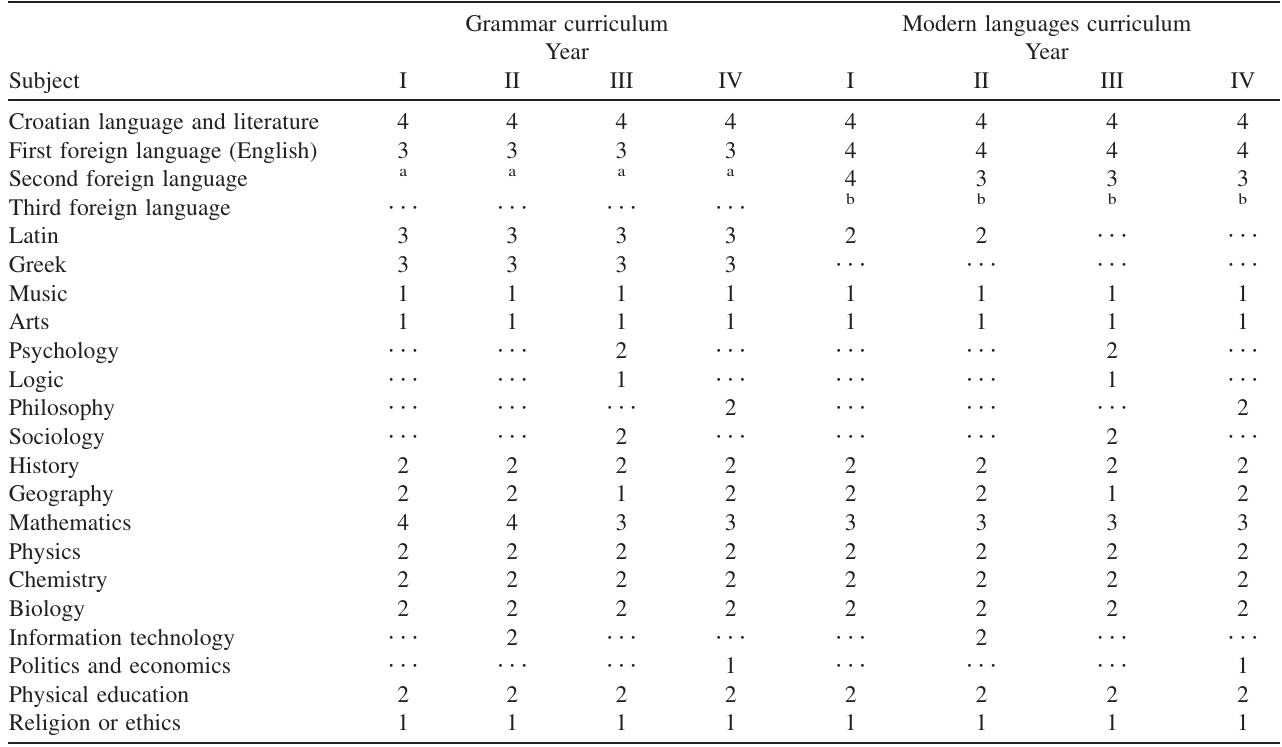
TABLE I. Syllabus in the grammar school and modern languages oriented high school. Grammar